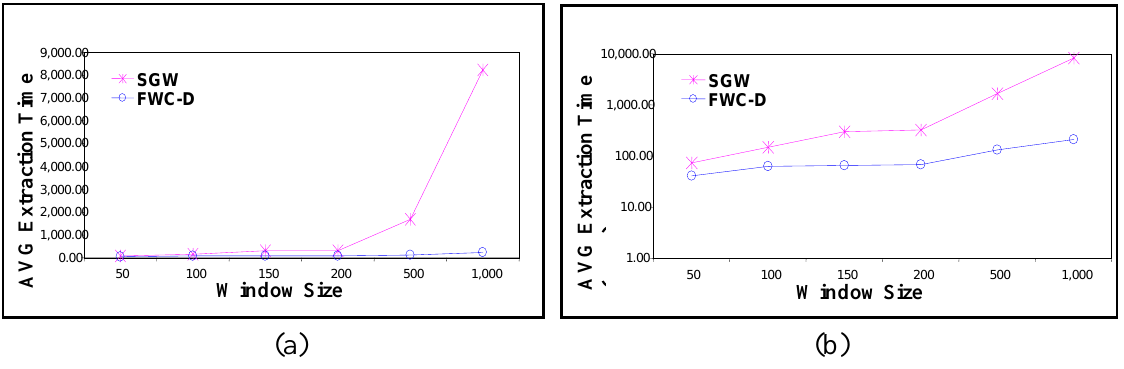
Figure 11. Execution time of the Integrity check algorithm at the receiver side. ( a ) Linear Scale, ( b ) Logarithmic Scale.